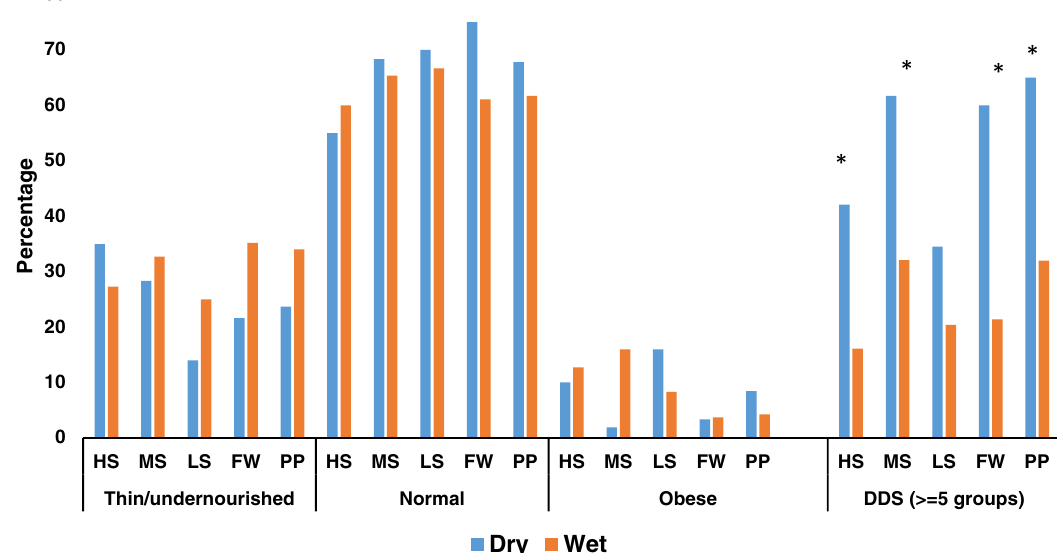
Figure 2. Nutritional status of adolescent girls by the salinity and seasonality. BMI-for-age of adolescent girls was measured during dry (August to September 2017) and wet (April to May 2018) season. Ref: Underweight (< -2SD >), Normal weight (-2 SD to + 1 SD), and Overweight (> + 1 SD). Dietary diversity score ≥ 5 (in last 24 h) among adolescent girls. Statistical significance ( P < 0.005) has been denoted by asterisk: *Pearson’s chi-square test. Note: Different agro-aquatic ecological zone- HS, High saline; MS, Medium saline; LS, Low saline; FW, Fresh water, and PP, Processing plant.